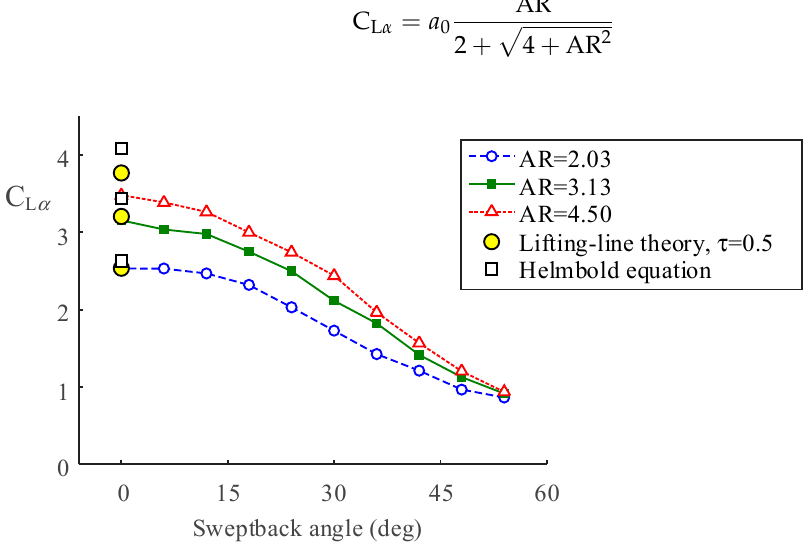
Figure 5. The slope of the C L – α curves in the pre-stall region.